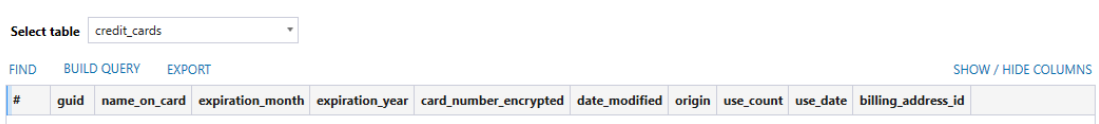
Figure 3. Unused data table seemingly meant to hold credit card data shown in DB Browser for SQLite.